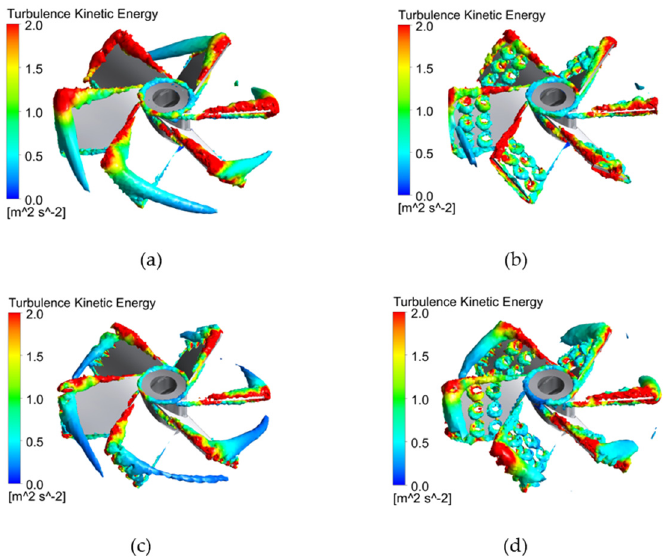
Figure 9. Three-dimensional structure of trailing vortex behind different impeller blades colored by turbulence kinetic energy. ( a ) PBT, ( b ) PBPT, ( c ) BCBT, ( d ) BCPBT.